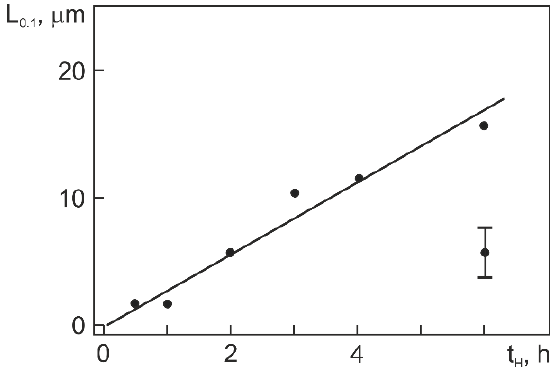
Figure 5. Depth L 0.1 with hydrogen signal level of 10% from its maximum vs. hydrogenation time in Ti 49.4 Ni 50.6 (at%).